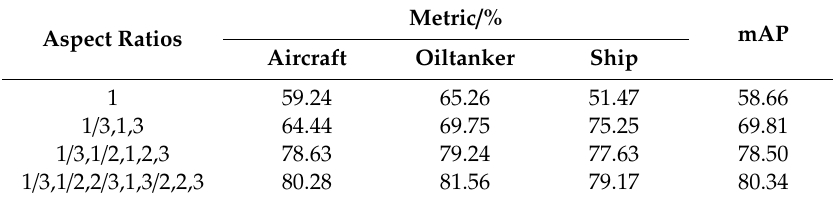
Table 4. Ablation study: E ff ects of di ff erent aspect ratios on the remote sensing image dataset